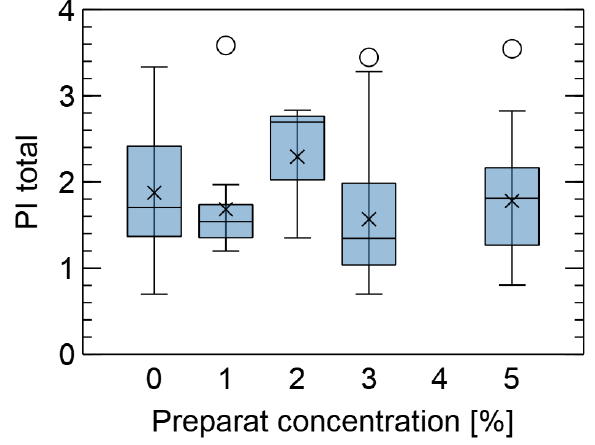
Figure 6. Photosynthesis efficiency (PI total) versus silicon concentration, for the measurements of oaks’ leaves. The trends in data, as fitted by the regression model, were not found to be statistically significant at the p -value level of 0.05. In the plot, boxes span from the 1st to 3rd quantile, with the median indicated by a line, whiskers indicating a 1.5 inter-quantile range, the × symbol indicating the mean value, and circles indicating outlier observations.